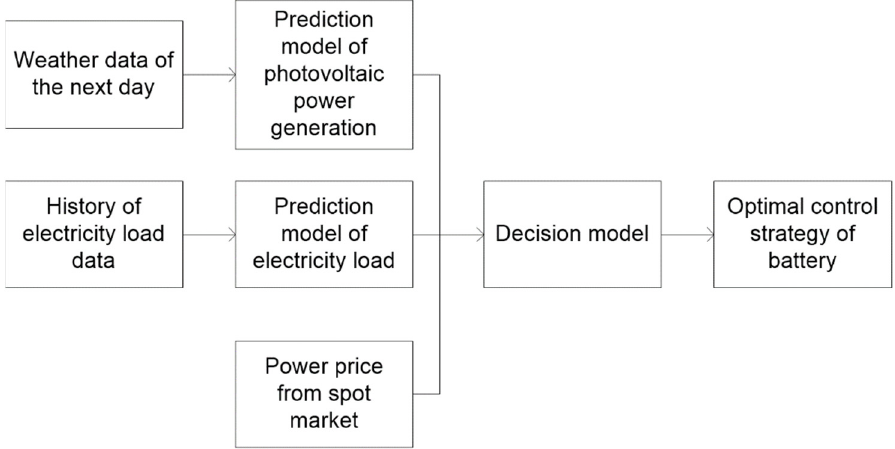
Figure 1. Framework of Energy Management.